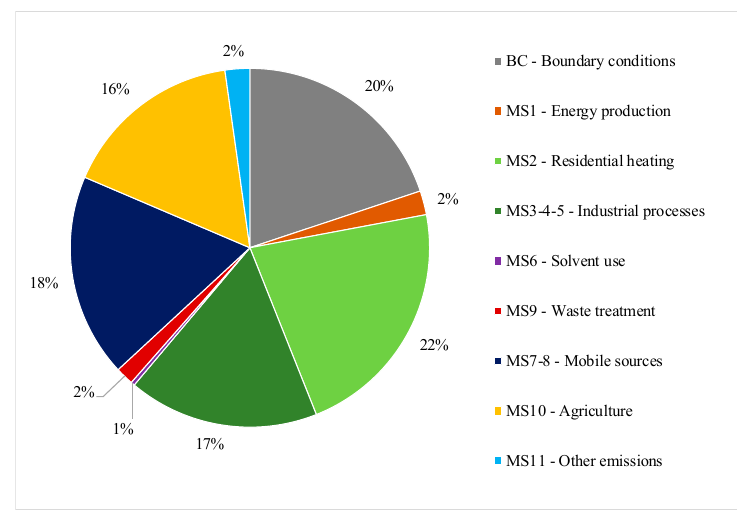
Figure 3. PM10 Source apportionment results in the Lombardia region.